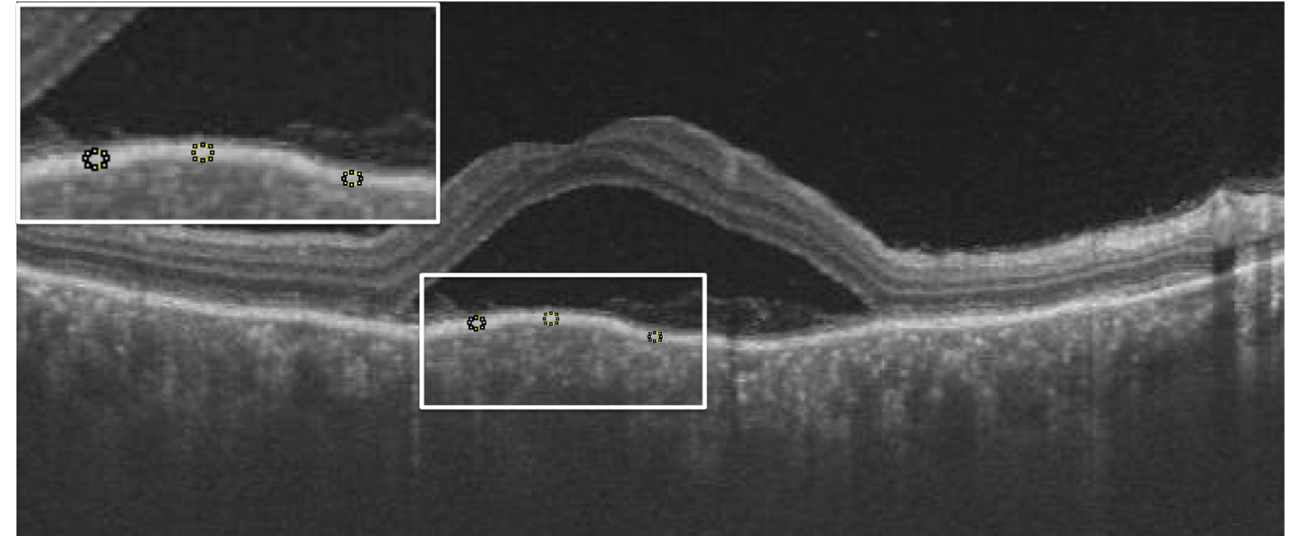
Figure 1. Example showing measurement of retinal pigment epithelial (RPE) reflectivity (white dotted circles in the white box inset at top left corner) below detached retina using ImageJ software. An average of the values from these three areas were taken for RPE reflectivity in detached retina. Similar measurements were taken under attached retina and subfoveally in all eyes.